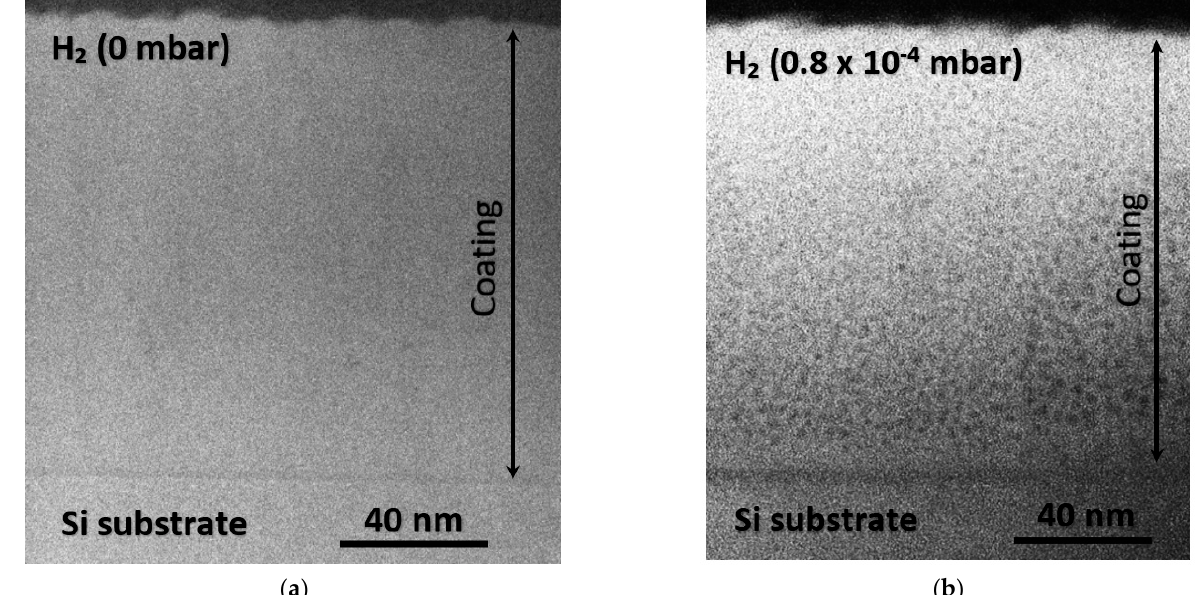
Figure 3. HAADF-STEM images of a-SiN x layers: ( a ) hydrogen-free a-SiN x layer and ( b ) a-SiN x :H.